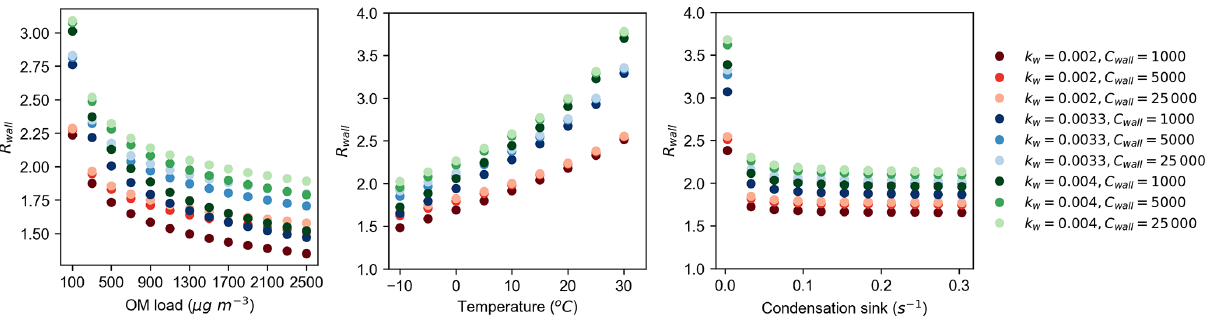
Figure 2. Dependence of the wall loss factor R wall (C OA ,k sink.